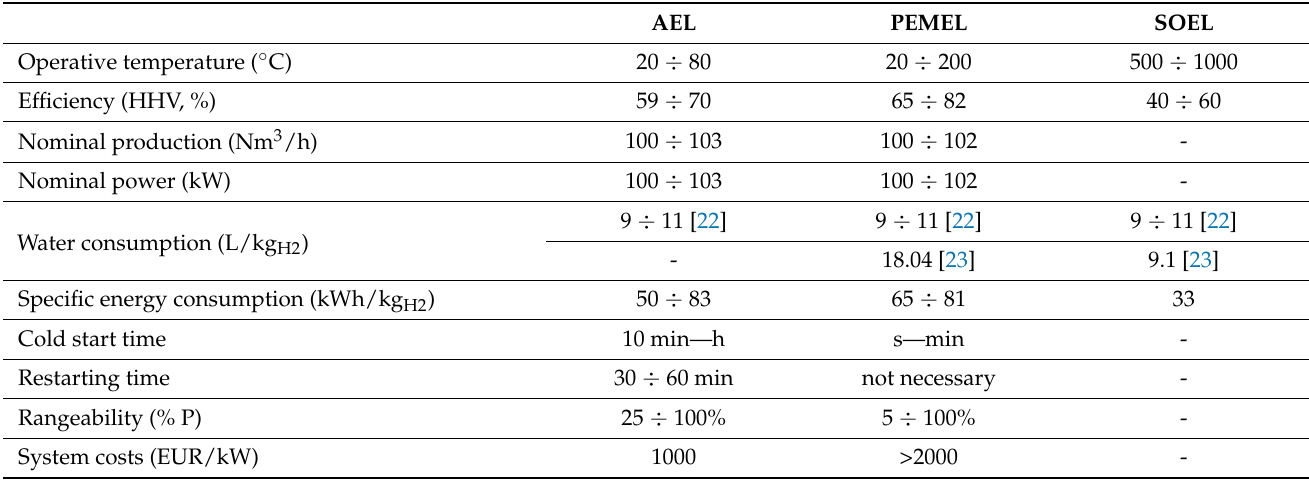
Table 4. Main characteristics of the electrolysis technologies [19–23]. AEL